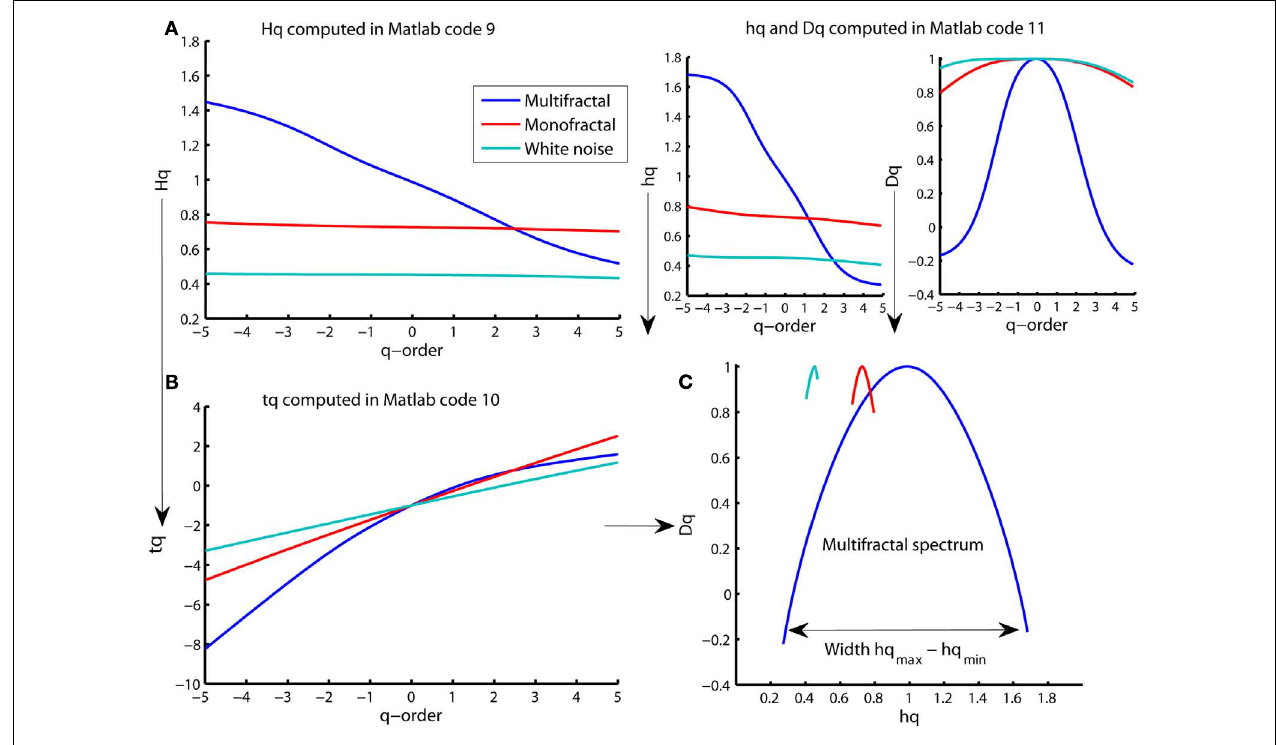
Matlab code 11 and plotted against each other.The arrow indicates the difference between the maximum and minimum hq that are called the multifractal spectrum width. Notice that the constant Hq for monofractal and whitenoise times series leads to a linear tq that further leads to a constant hq and Dq that, finally, are joined to become only tiny arcs in (C)